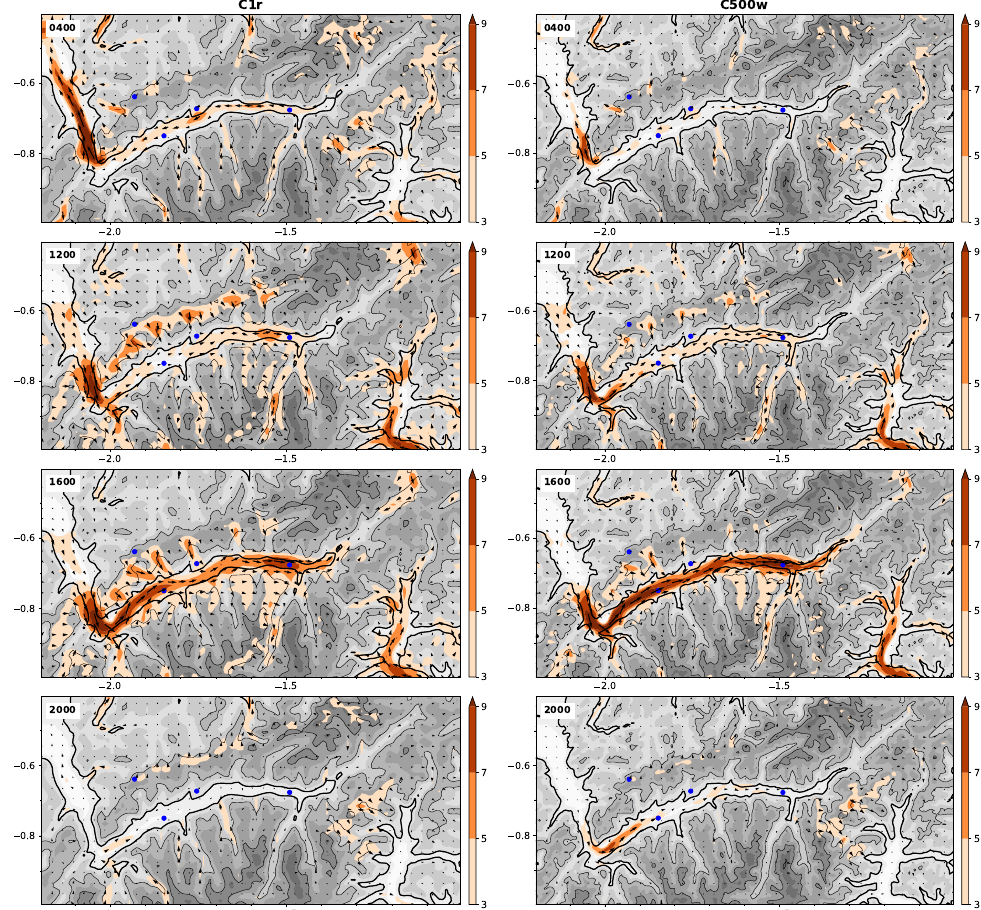
Figure 9. Mean diurnal cycle of the valley winds in Wallis for the valley wind days in September 2016. Wind speed (shading) and direction (vectors) at ca. 200 m AGL (10th model level). Time is indicated in the top left corner. Location of four surface stations (blue discs; see Figure 1). Gray shading indicates the terrain height (500 m contour interval) and the bold black line indicates the 1000 m